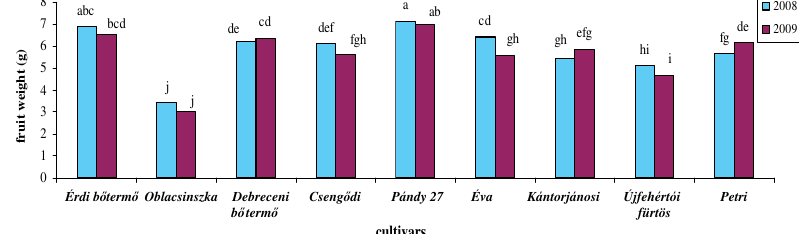
Figure 5. Fruit weight of the studied sour cherry cultivars in tow years (2008 & 2009). Different letters indicate significant differences between treatments (P